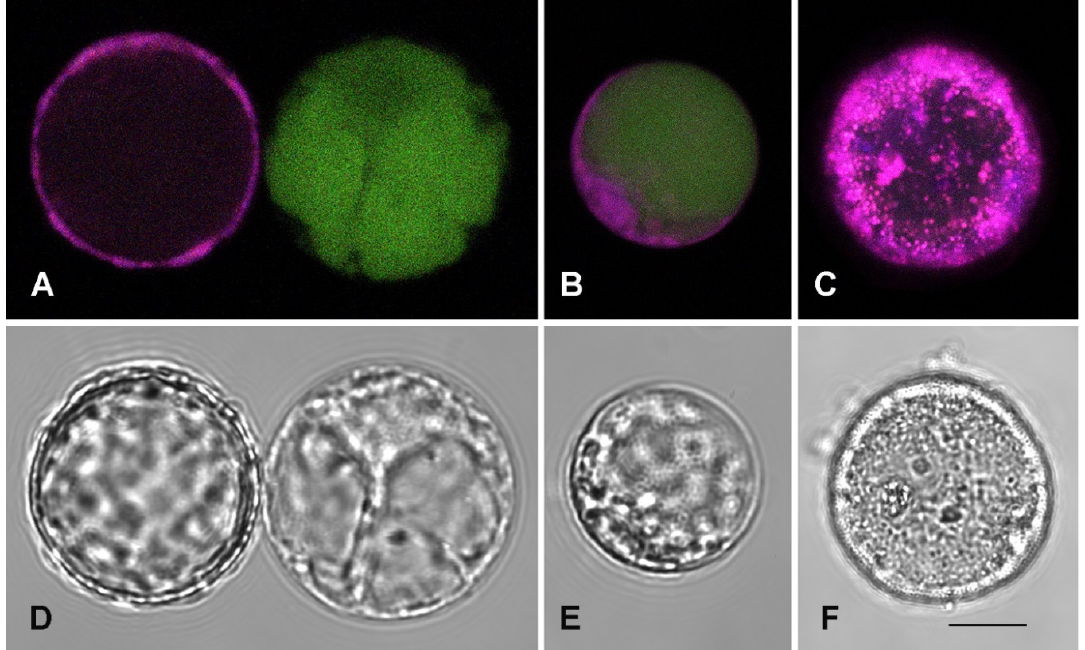
Figure 5. Autofluorescent protoplasts from saffron calli. ( A ) Two protoplasts showing opposite fluorescent patterns, on the left one with only orange-to-red emission (magenta color) in the cytosolic organelles (and little fluorescence in the central vacuole), the other on the right with only green emission in the central vacuole. ( B ) Protoplast from the same population with both emission patterns. ( C ) The most common fluorescent pattern showed by protoplasts treated with SA 1 mM. ( D , E ) Cells in control conditions do not show signs of stress. ( F ) SA treatment causes visible stress in a protoplast. Scale bar 10 µm.